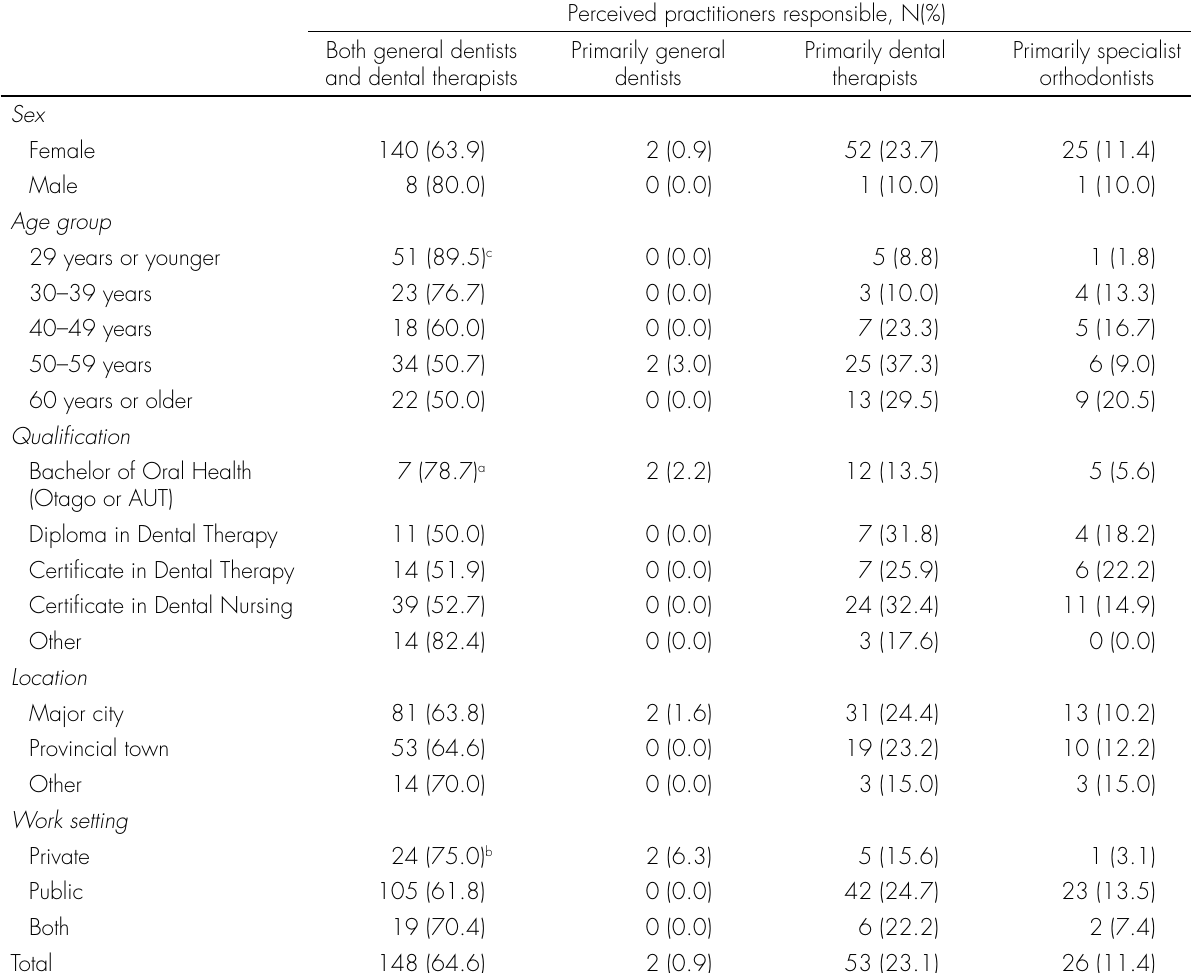
Table III. Opinion of oral health practitioners responsible for orthodontic screening by demographic